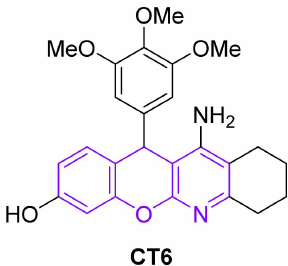
Figure 1. Chromenotacrine CT6.